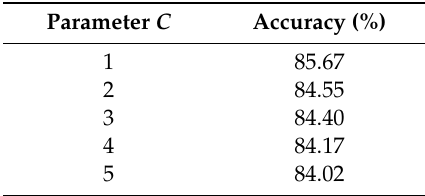
Table 8. Accuracy of the di ff erent parameter C on MIT indoor 67